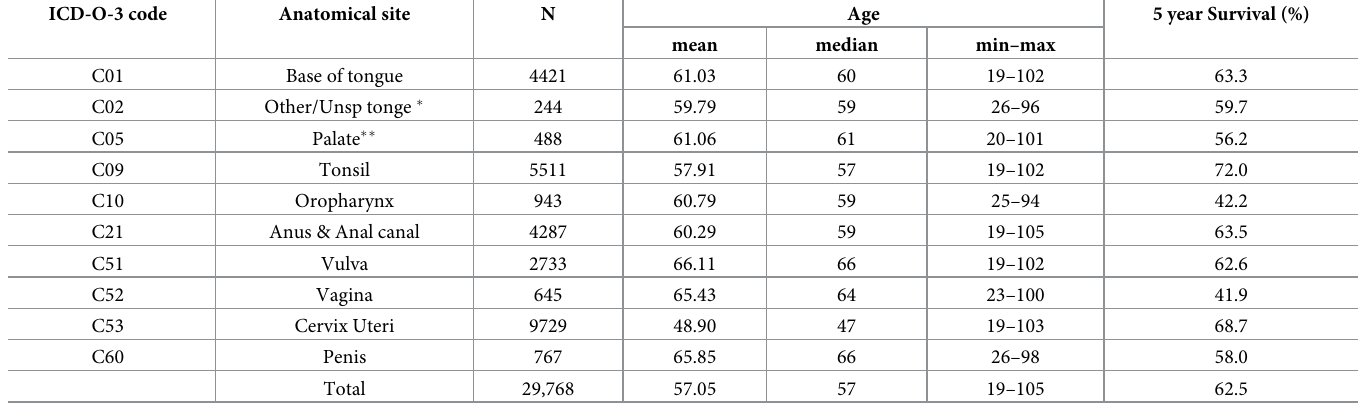
Table 1. Population data description per anatomical site, classified by ICD-O-3 topography codes: Number of cancer cases (N), age information, and 5-year survival